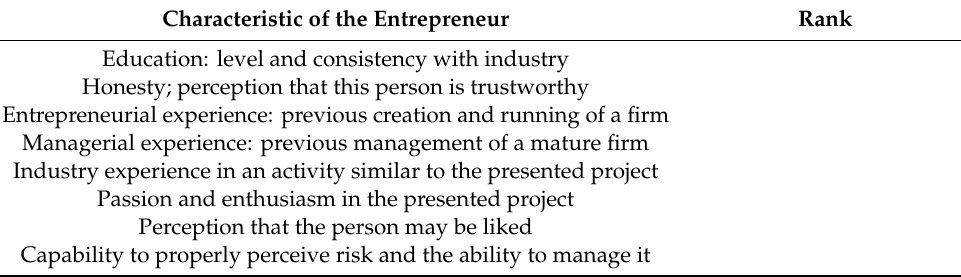
Table 4. Characteristics of the entrepreneur assessed by VC managers in the